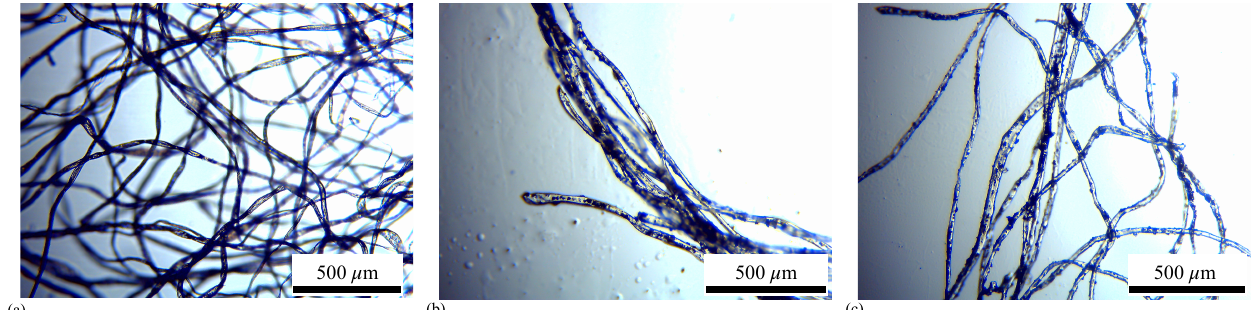
Figure 3. Optical microscopy images of magnetizable CMs. ( a ) Cotton microfibers (M 1 ). ( b ) Cotton microfibers with honey (light blue) and silver microparticles (gray spots on cotton microfibers) (M 3 ). ( c ) Cotton microfibers with honey (light blue), silver microparticles (gray spots on cotton microfibers), and CI (dark spots) (M 4 ). See the main text and Table 2 for details.